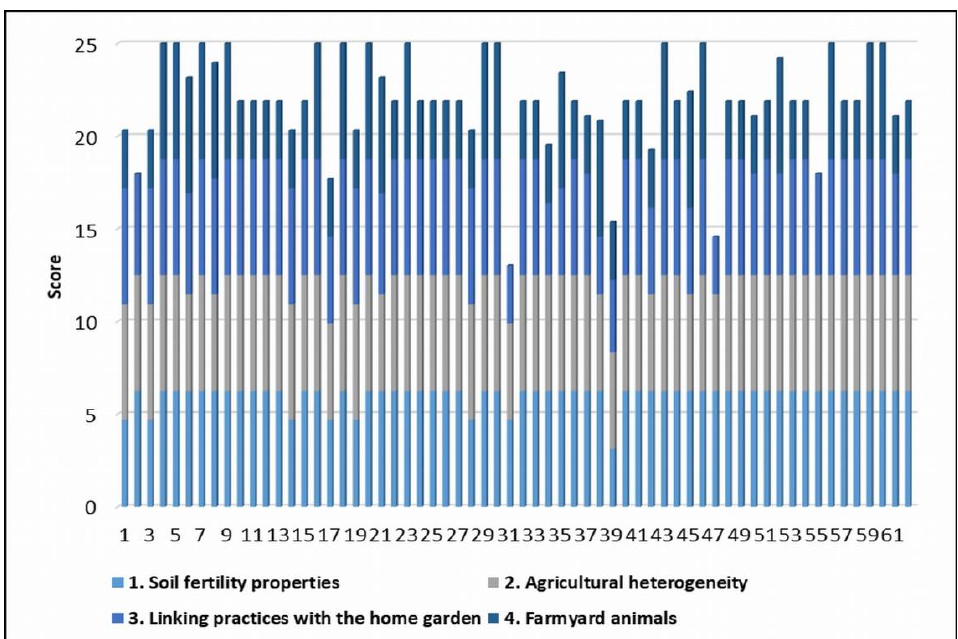
Figure 2. Accumulated value per home garden for the diversity-resilience indicators.